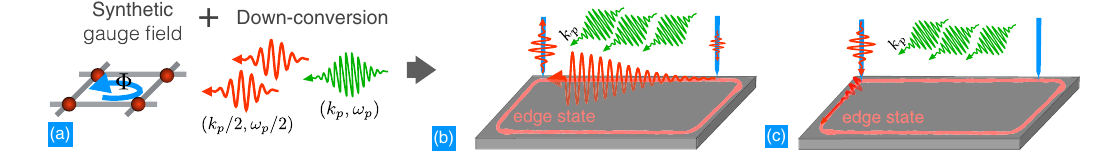
FIG. 1. Setup figure. (a) Scheme of the basic interactions. (i) Photons hopping anticlockwise around a plaquette pick up a phase Φ that and quasimomentum k are down-converted into can be interpreted as a synthetic gauge field flux. (ii) Pump photons with frequency ω p p = 2 and quasimomentum k = 2 . (b),(c) Combining the two interactions in a finite geometry allows one to a photon pair with frequency ω p p engineer a topologically protected quantum-limited amplifier. A signal injected into the device via a tapered fiber propagates unidirectionally along the edge. (b) With the appropriate choice of pump frequency ω and quasimomentum k , the signal is amplified p p while it travels along the upper edge. A second tapered fiber detects the amplified signal. (c) When the input and the output fiber are exchanged, the signal propagates along a different path where it decays due to the lack of phase matching. This leads to nonreciprocal